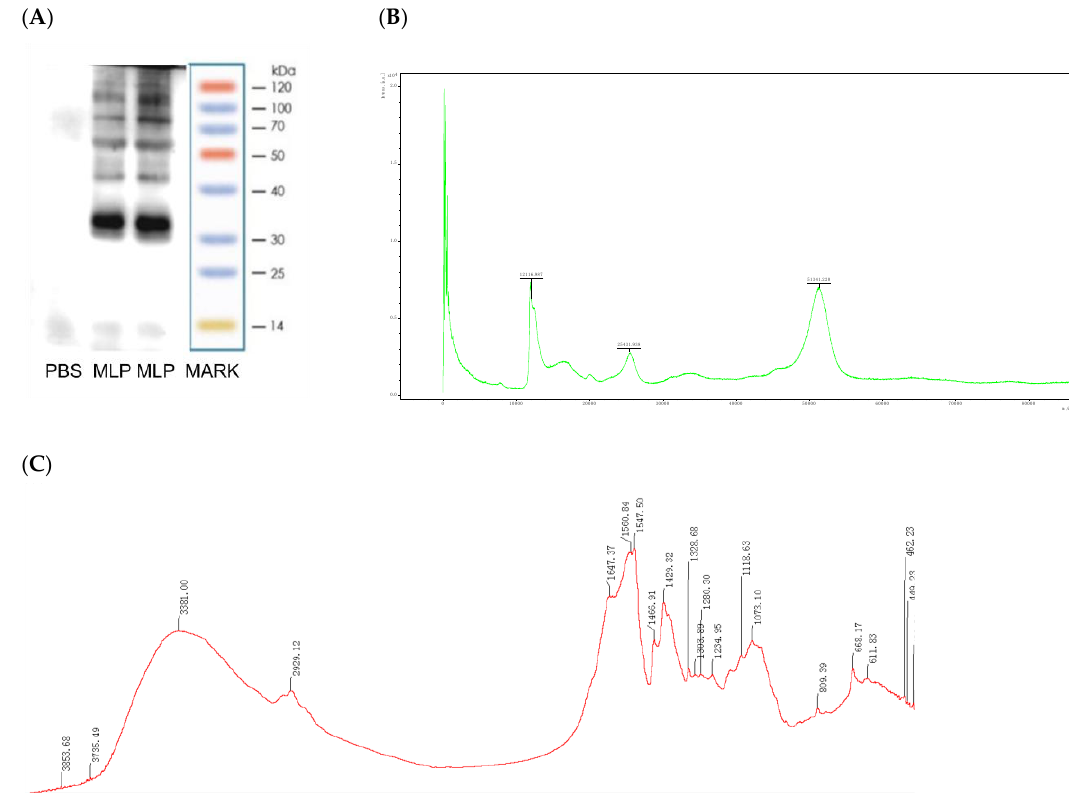
Figure 2. SDS-PAGE ( A ), MALDI-TOF MS ( B ), and Fourier transform infrared spectroscopy spectra ( C ) for MLP.